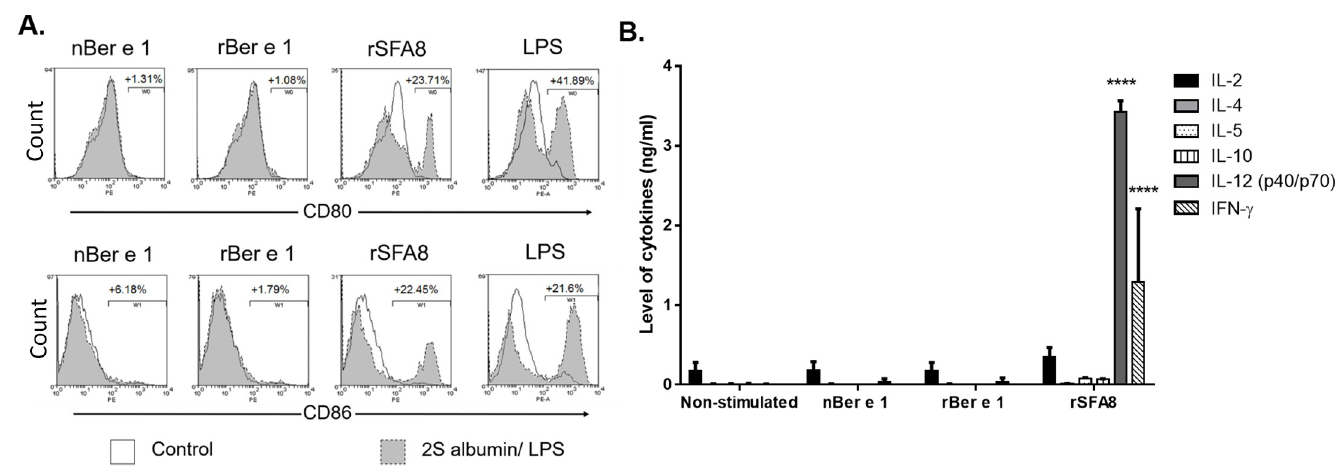
Fig 6. Co-stimulatory molecular markers and Th1/Th2 cytokine production upon CD11c + bmDC stimulation with 2S albumins. (A.) Percentage population of CD80 + or CD86 + bmDC post stimulation with 50 μ g/ml rBer e 1, nBer e 1, or rSFA8, or 10 ng/mL LPS (positive control) were normalised to non-stimulated bmDC. (B.) Level of Th1 (IL-12, and IFN- γ )—and Th2 (IL-2, IL-4, IL-5)-specific cytokines detected in bmDC stimulated with 50 μ g/ml of nBer e 1, rBer e 1 rSFA8 or 10 ng/ml LPS were measured after 24 hours by Luminex assay. Data are from three biological replicates and presented as mean ± SD ( ���� , p < 0.0001) relative to non-stimulated